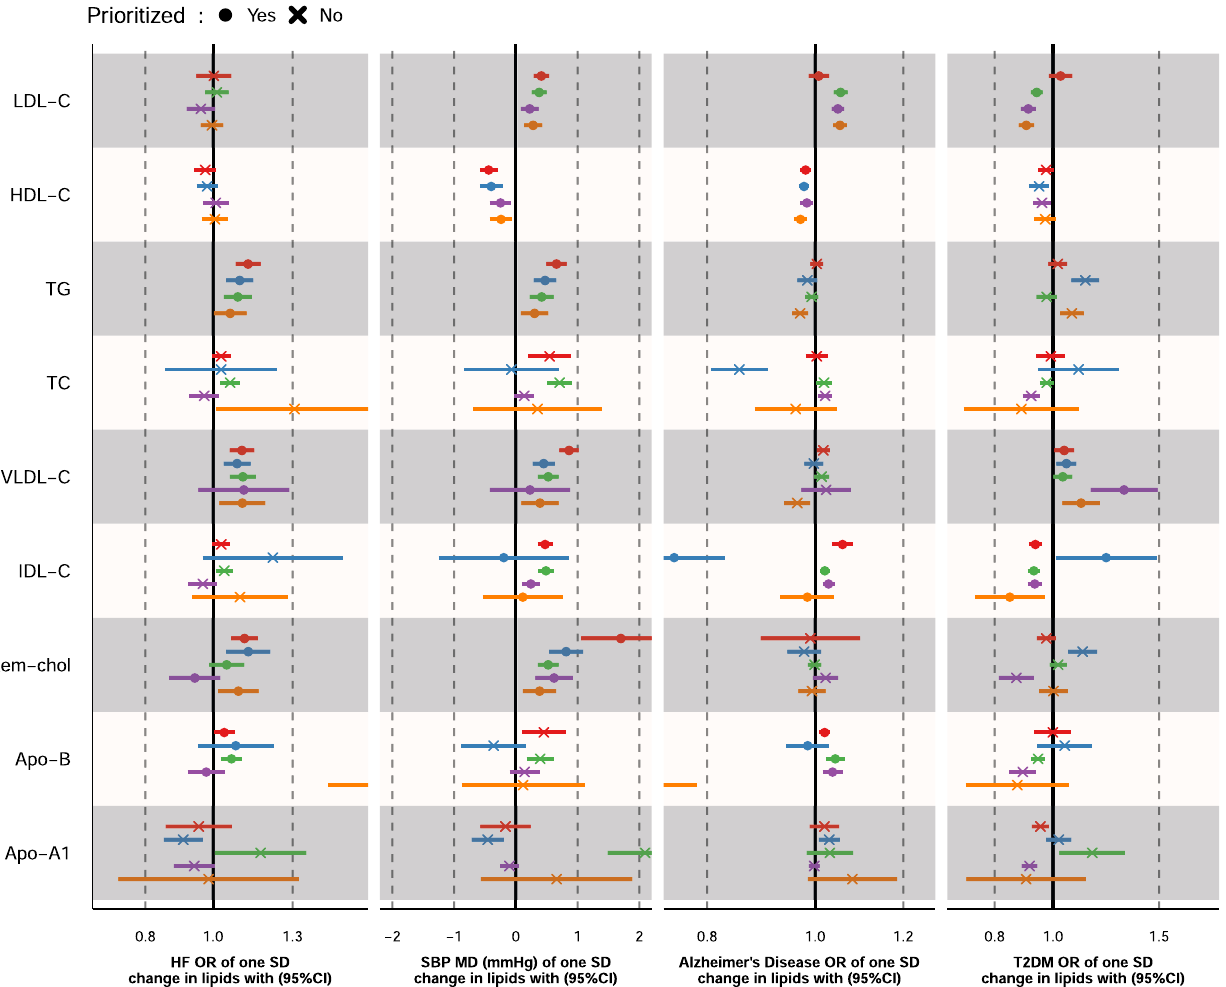
Fig. 5 Mendelian randomization effect estimates of a standard deviation change in cholesterol-containing lipoprotein or apolipoprotein concentration on heart failure (HF), systolic blood pressure (SBP), Alzheimer ’ s disease (AD), and type 2 diabetes (T2DM). Prioritized results re fl ect associations depicted in the causal network of Fig. 3, where 3 out of 5 (or 4 for LDL-C, HDL-C, and TG) estimates were signi fi cant at an alpha of 0.05 and directionally concordant. Total: the total lipid effect, Conditional effects either, represent the blood lipid effect of LDL-C, HDL-C or TG singularly, or off all three blood lipids in a single multivariable MR (fully adjusted) model. Fully adjusted models for LDL-C, HDL-C, or TG exposures only conditioned on two of the three blood lipids (e.g., the fully conditional model for LDL-C exposure only conditioned on HDL-C and TG). Analyses were based on a 33,029 subject meta- analysis of Kettunen 15 and UCLEB 20 . Estimates are provided as odds ratio (OR) or mean difference (MD) with 95% con fi dence intervals